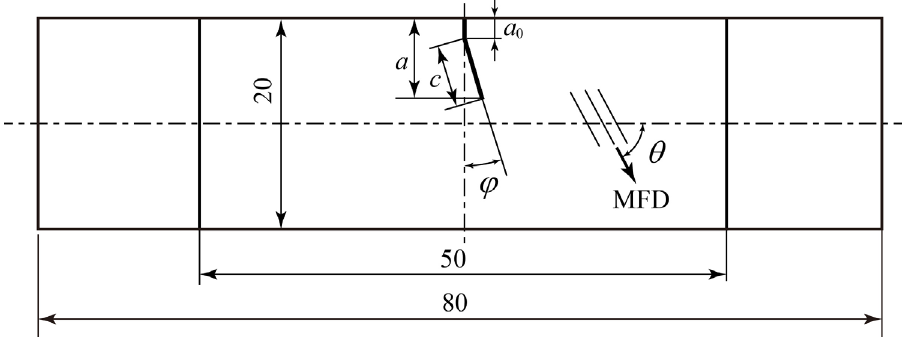
Figure 1: Single edge notched